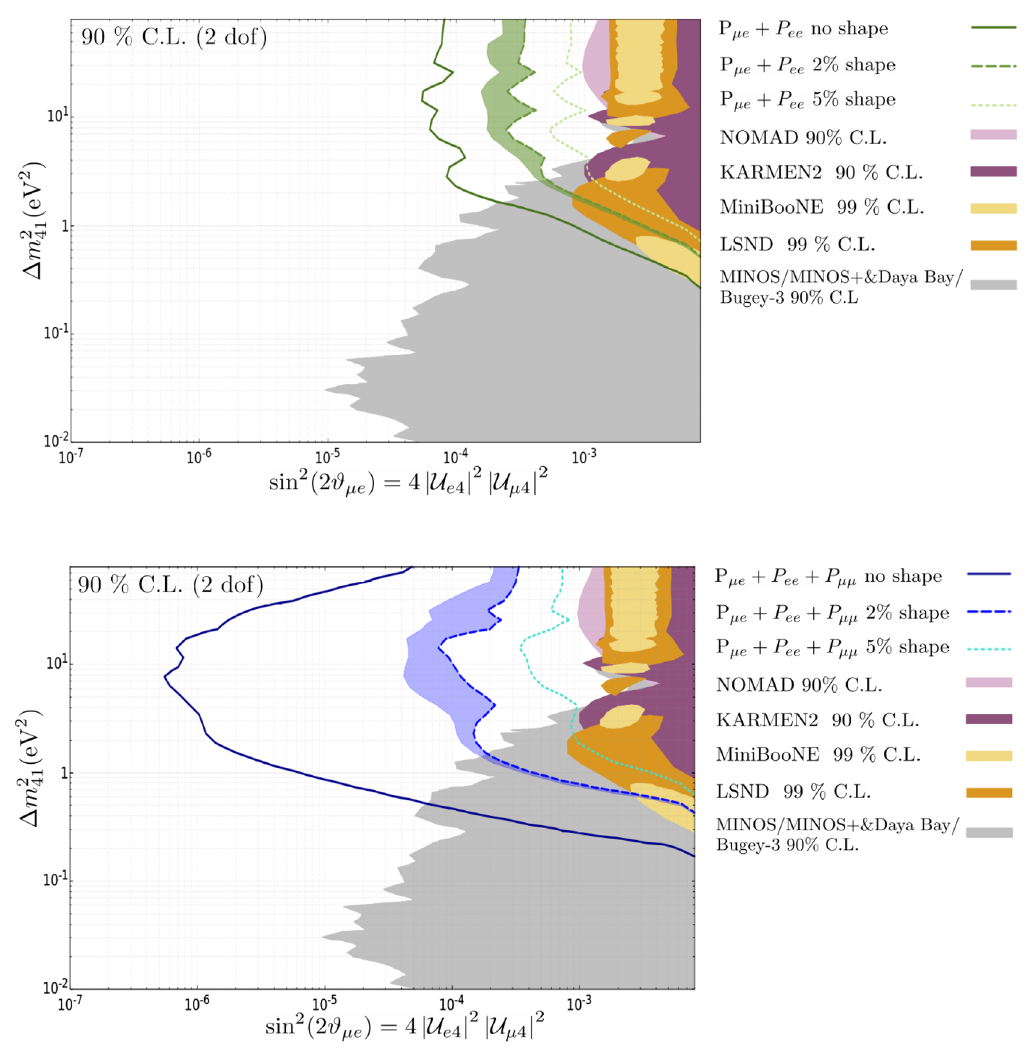
Figure 5 . Expected sensitivity to the sterile neutrino scenario, for oscillations in the P µe channel. Results in the upper panel only include information from the ν e -like sample, while in the lower panel we have added the information from the ν µ -like sample as well. The shaded pink, purple and gray areas show current constraints from other experiments at 90% CL [64, 101, 103], while the shaded yellow/orange regions are favored at the 99% CL by the LSND [36] and MiniBooNE [37] anomalies. The colored lines indicate the sensitivity for the DUNE ND, for different choices of systematic uncertainties as indicated by the legend. In each case, the region to the right of the lines would be disfavored at 90% CL (2 d.o.f.). Finally, the shaded band to the left of the dashed lines indicate the increase in sensitivity due to the addition of 3.5 years of data taken in the HE